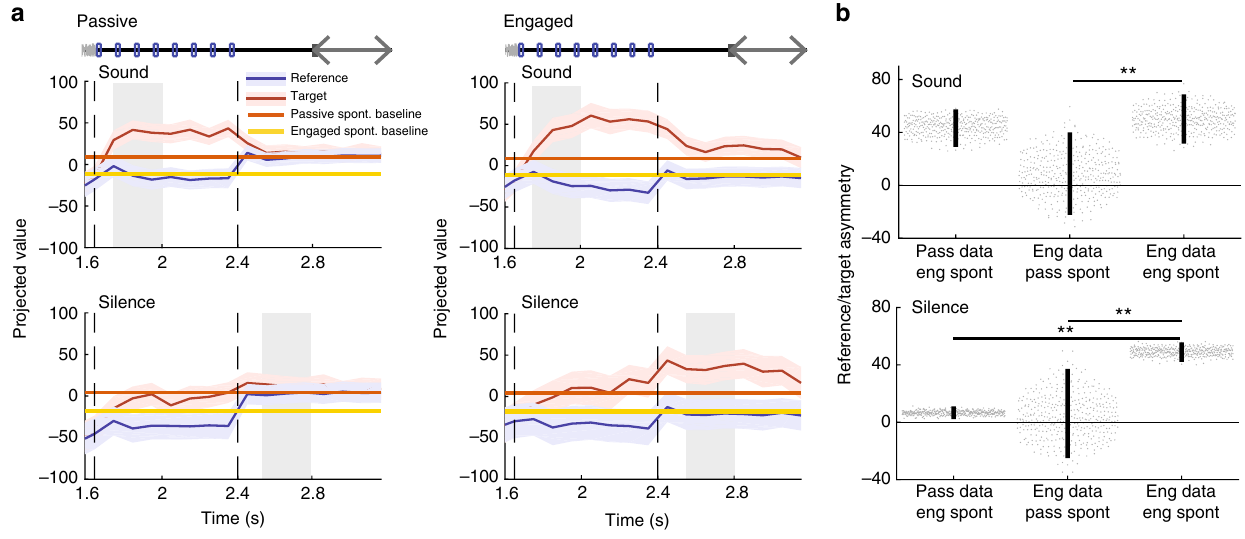
Fig. 5 Shift in spontaneous activity contributes to change in asymmetry. a Projection onto the engaged decoding axis of reference- and target-evoked activity in the passive (left column) and engaged state (right column). Decoding axes determined during sound presentation and post-stimulus silence are, respectively, used for projections in the top and bottom rows. This fi gure differs from Fig. 3c in which the spontaneous activity is subtracted before projection, so 0 corresponds to the null space of the projection. Passive and engaged spontaneous activities after projection are shown by continuous lines. Error bars represent 1 std calculated using decoding vectors from cross-validation ( n = 400). b Comparison of reference/target asymmetry for evoked responses in different states compared to different baselines given by passive or engaged spontaneous activity. Reference/target asymmetry is the difference of the distance of reference and target projected data to a given baseline. We examine three cases: (i) passive evoked responses, distances calculated relative to engaged spontaneous activity; (ii) engaged evoked responses, distances calculated relative to passive spontaneous activity; (iii) engaged evoked responses, distances calculated relative to engaged spontaneous activity. These values are shown during the sound (top) and the silence (bottom). In all three cases, the engaged decoding axis was used for projections. Decoding axes determined during sound presentation and post-stimulus silence are, respectively, used for projections in the top and bottom rows Note that all analysis in this fi gure is done after excluding lick-responsive units in A1 as described in Fig. 4. Error bars represent 95% con fi dence intervals ( n = 400 cross-validations; sound: p (col1,col3) = 0.29 and p (col2,col3) < 0.0025; silence: p (col1,col3) < 0.0025 and p (col2,col3) < 0.0025; ** p <